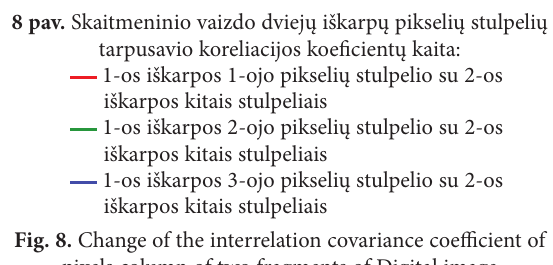
Fig. 8. Change of the interrelation covariance coefficient of pixels column of two fragments of Digital image